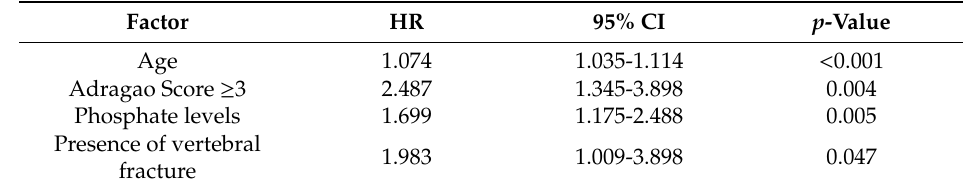
Figure 2. Kaplan Meier survival depending on the presence of vertebral fractures. Table 5. Multivariate Cox-proportional hazard model for risk factors of mortality in CKD patients not on